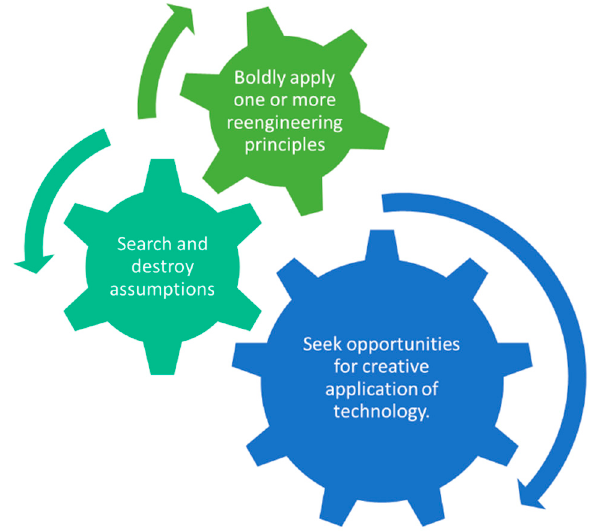
Figure 4. Seminars elaborated by the author, taking Hammer and Champy [1] as a reference.